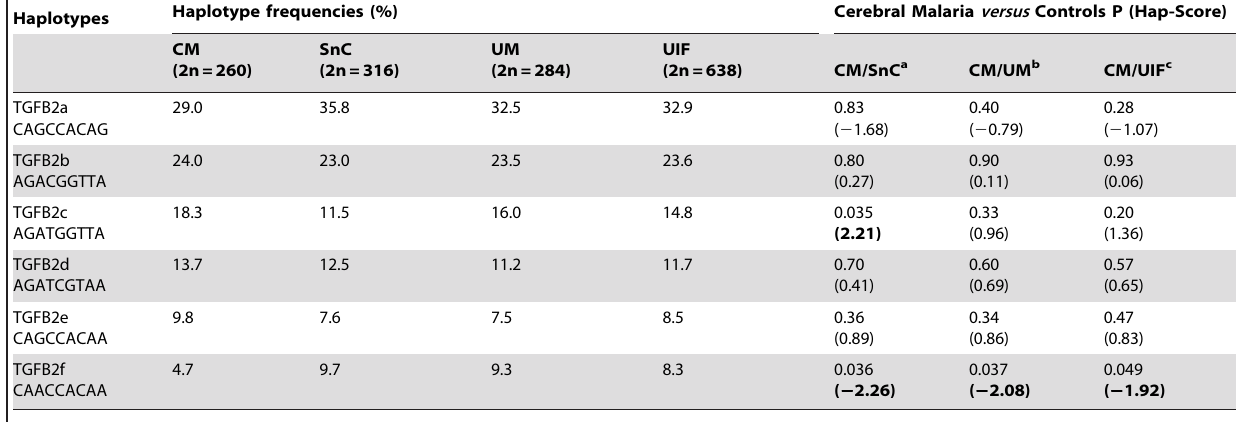
Table 2. Association results for TGFB2 haplotypes.